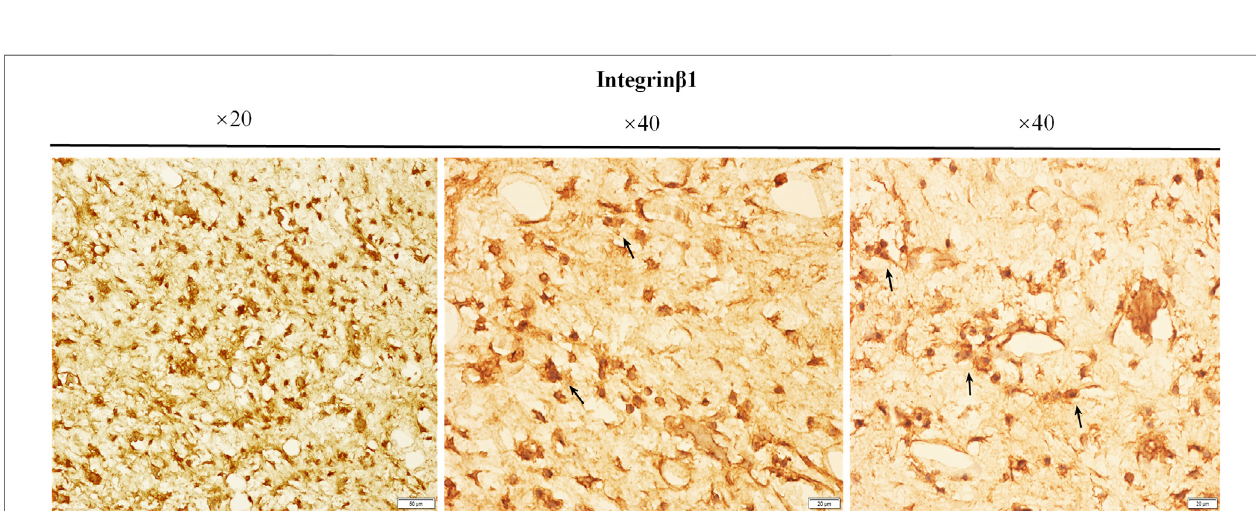
Frontiers in Bioengineering and Biotechnology |